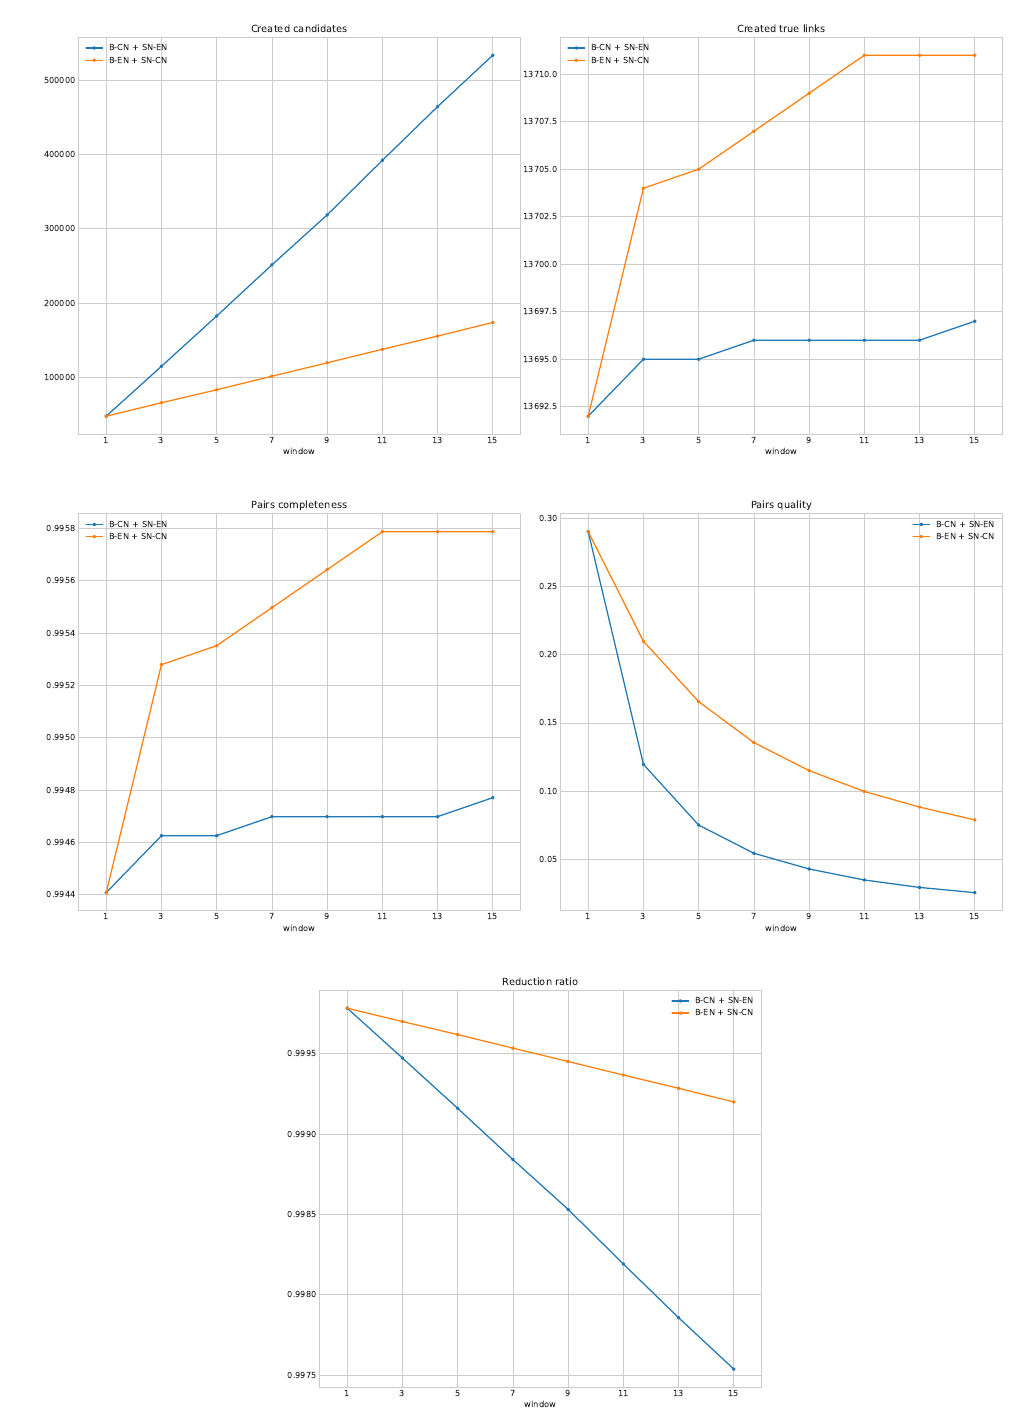
Figure 4. Comparison of two variants of hybrid indexing. B-EN + SN-CN applied to the reduced dataset outperformed B-CN + SN-EN for all window sizes. A window size equal to 3 was selected as the best, because the next window (5) provided a relatively small improvement in terms of PC, but a significant increase in the number of candidates. Statistics for the selected indexing configuration measured on the testing subset are depicted in Table